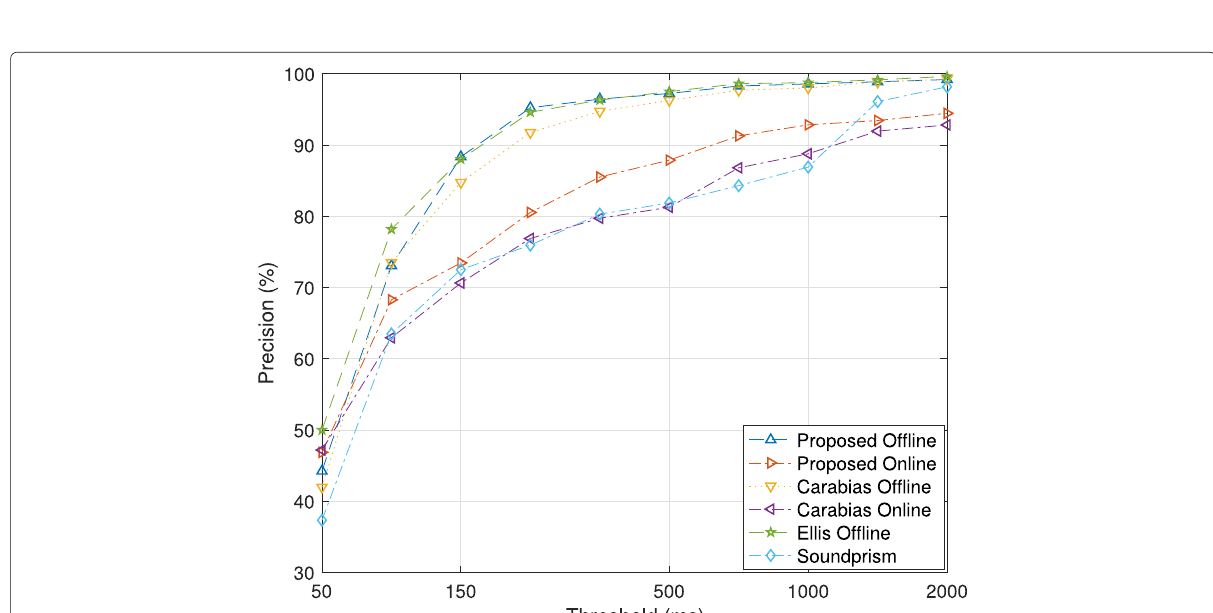
Fig. 5 Alignment evaluation over the URMP dataset in terms of precision values in function of the tolerance